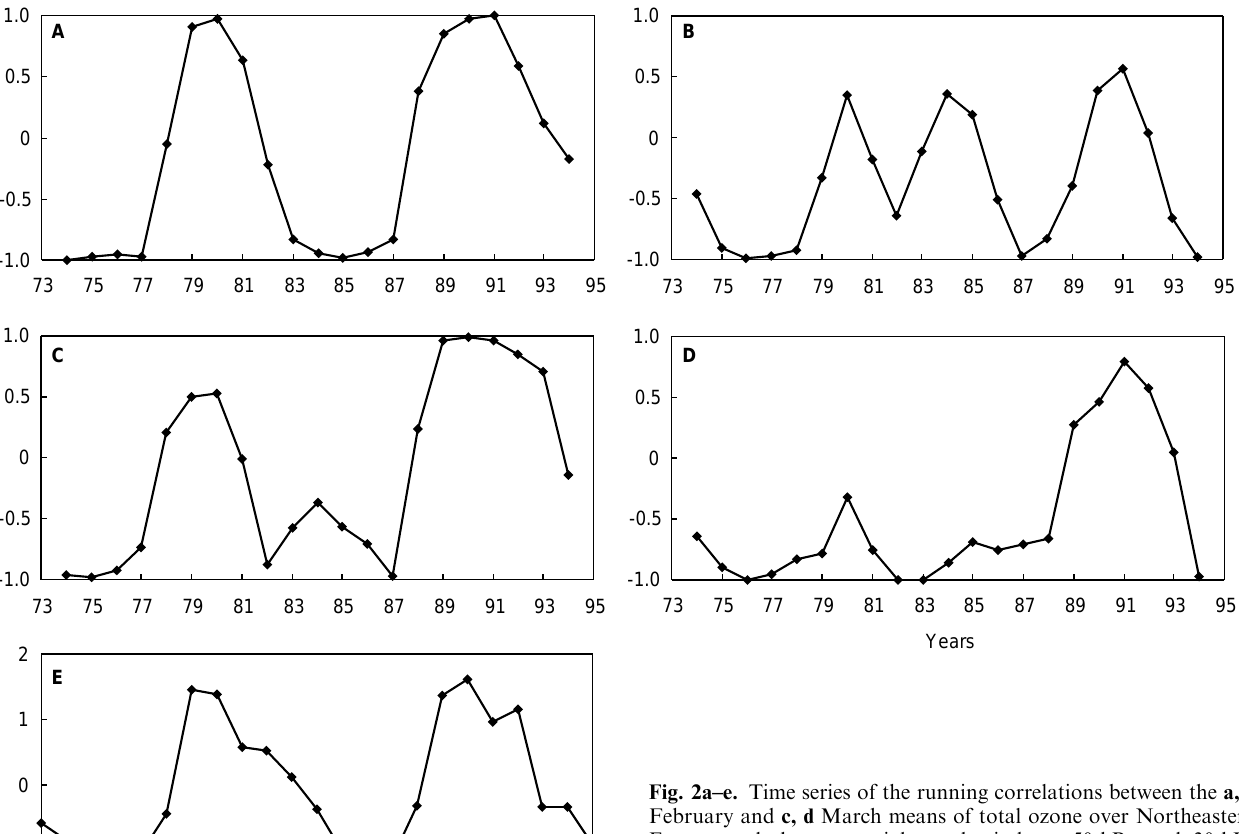
Fig. 2a–e. Time series of the running correlations between the a, b February and c, d March means of total ozone over Northeastern Europe and the equatorial zonal winds at 50 hPa and 30 hPa respectively. Running correlations are calculated using 3-year window width. e is time series of January mean sunspot numbers. All time series have been normalized ( procedure in Fig.